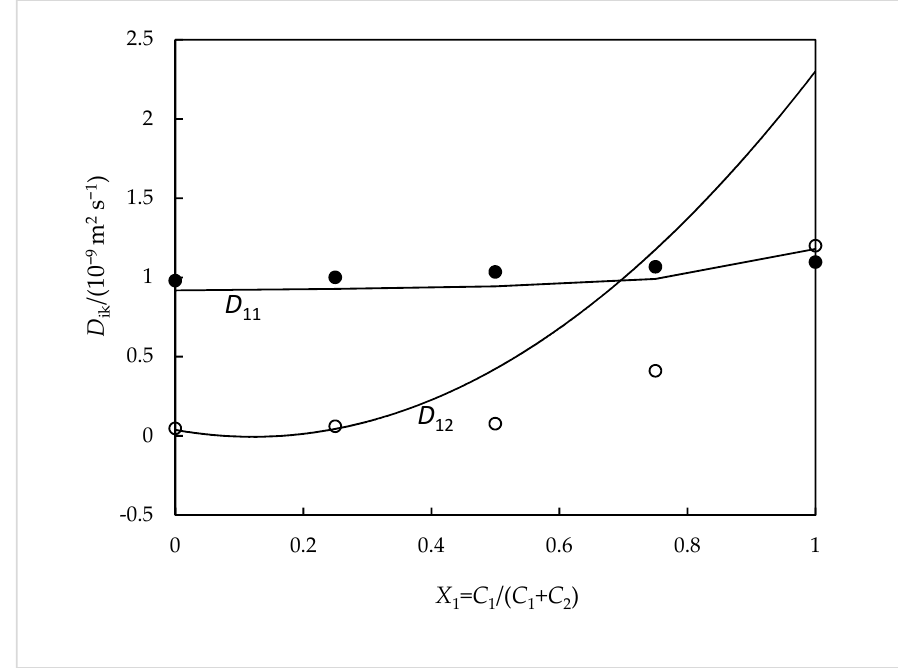
Figure 1. Ternary D ik coefficients for aqueous NaSal( C 1 ) + Na 4 EtRA( C 2 ) solutions containing 0.010 mol dm − 3 of total solute and their comparison with the predicted D ik coefficients calculated from the Nernst equations: D 11 , filled circles; D 12 , hollow circles. The solid curves represent Nernst predictions [15].